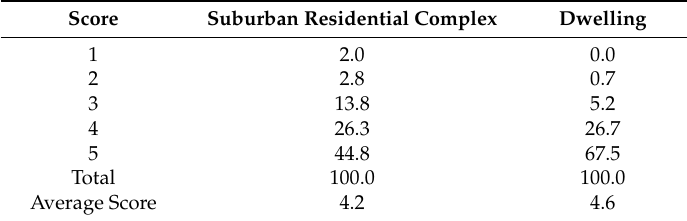
Table 5. Evaluation of the residential area and the dwelling, 2017.